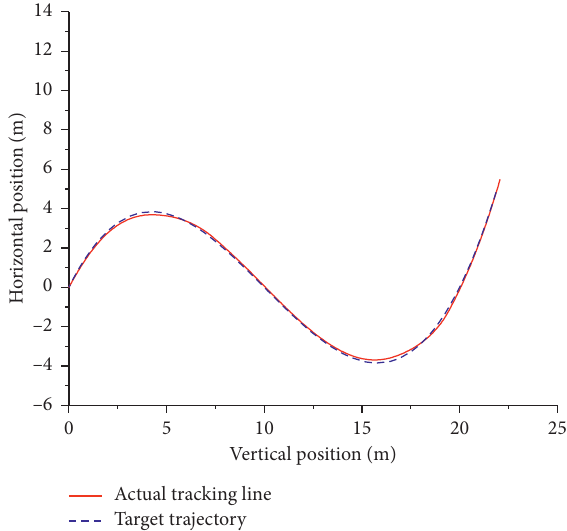
Figure 9: Straight-line tracking vehicle speed simulation diagram.